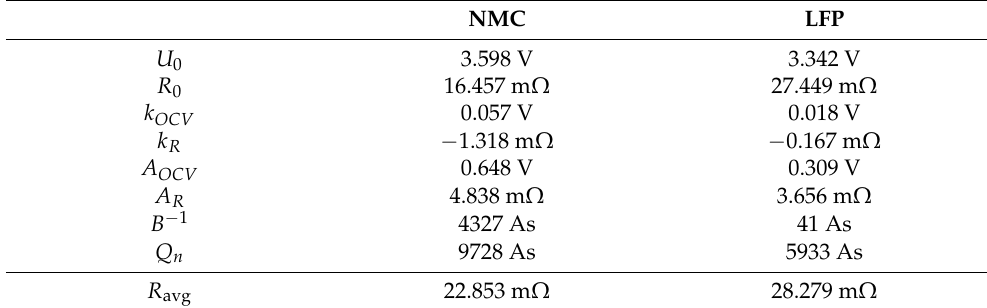
Table 1. Fitted and further used parameters on open-circuit voltage and internal